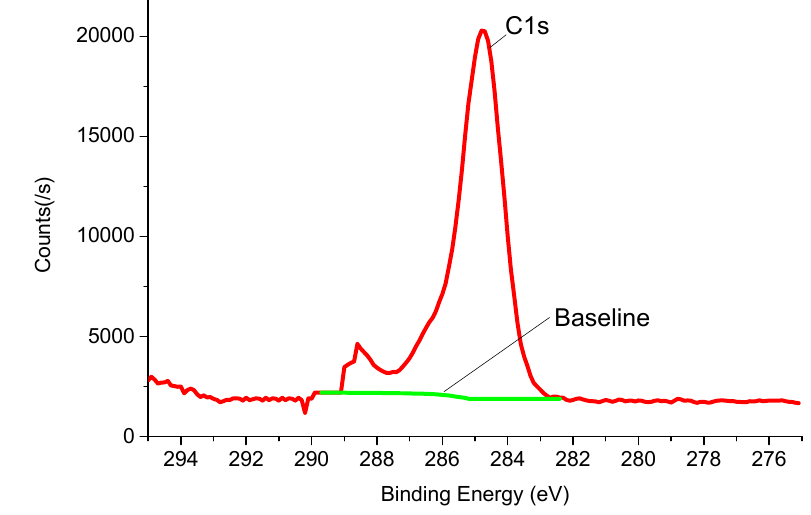
Figure 4. C element photoelectron scanning.